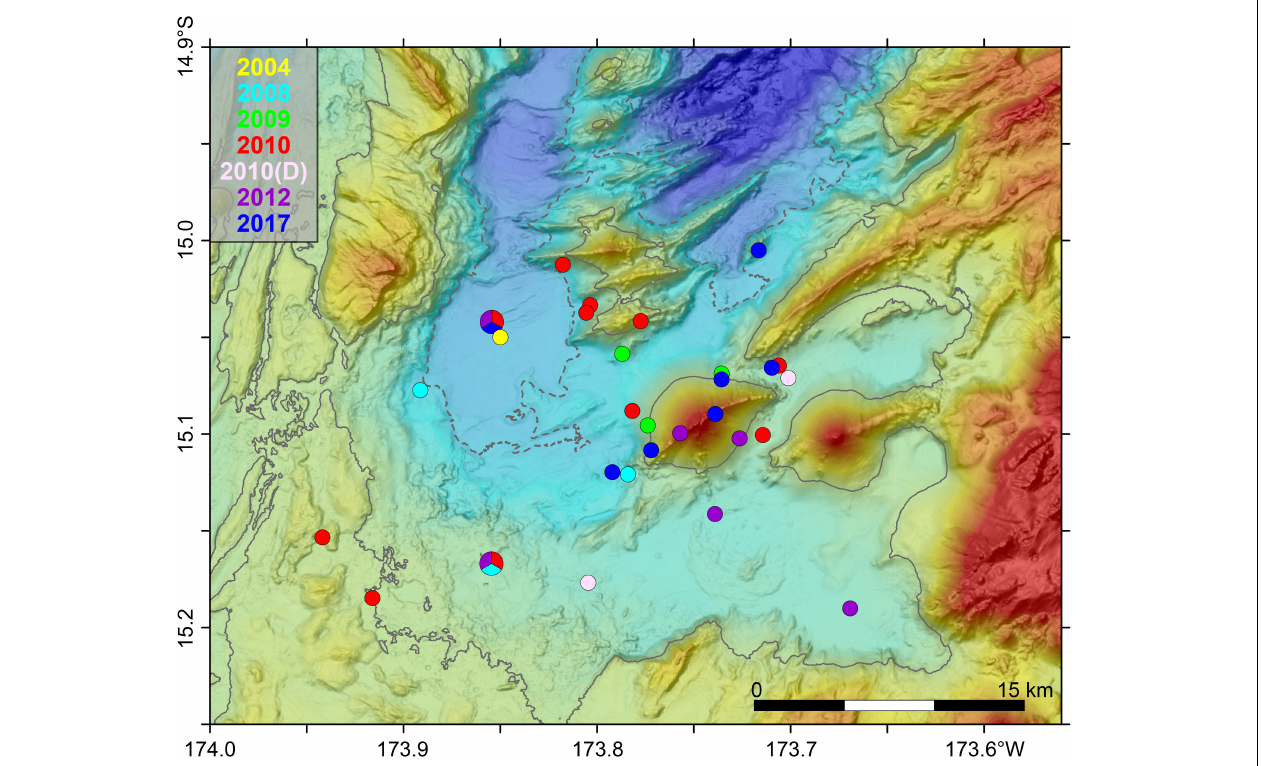
FIGURE 2 | Station locations for all profiles (2004 through 2017) used in this study. Symbol color indicates year. Larger multi-color symbols indicate station locations that were repeated in more than 1 year, with colors indicating which years that location was sampled. Depth contour intervals are: solid gray line = 2500 m, dashed gray line = 3000 m. See Supplementary Figure S1 for each location labeled with station name, and Supplementary Table S4 for a list of station locations. For CTD tows, only the initial downcast ( ↓ ) or final upcast ( ↑ ) was used, as indicated by arrows in labels for Figure 3 and Supplementary Figure S1